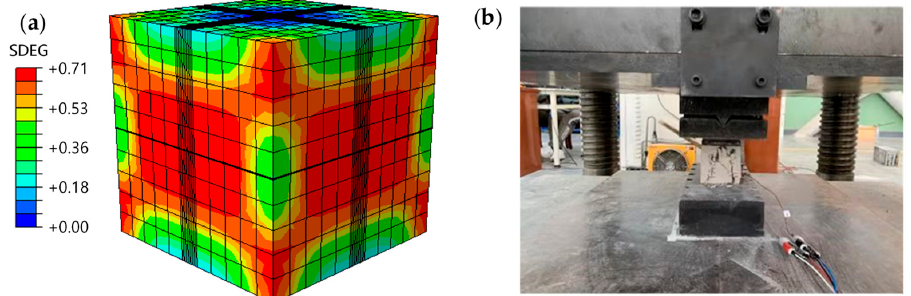
Figure 7. Typical embedding positions of PZT sensors with relative angles between the loading di- rection and normal vibration plane: ( a ) 0 ° and ( b ) 90 °